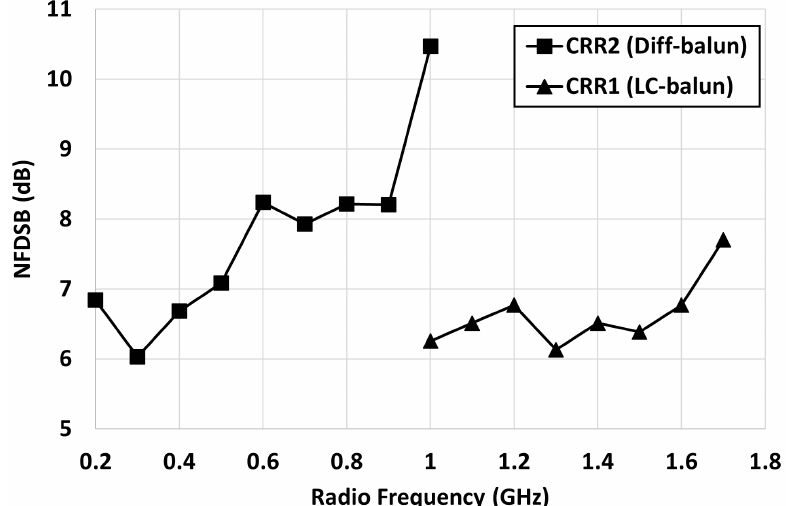
Figure 8. The NF performance CRR1 and CRR2 versus the RF input.